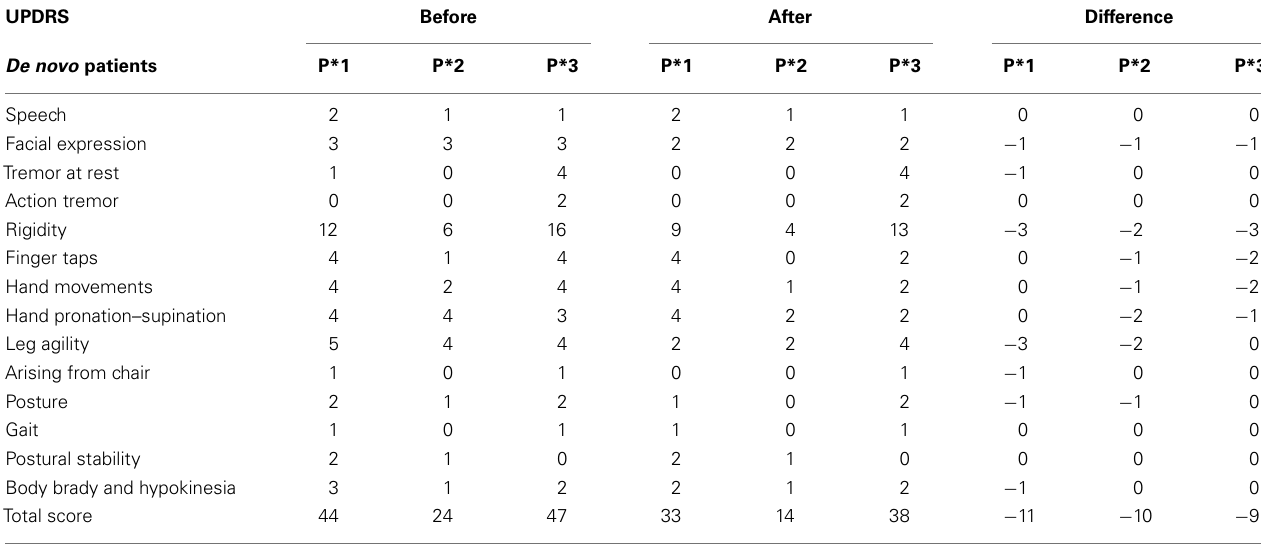
Table 3 | Unified Parkinson disease rating scale III results of the three de novo patients. UPDRS